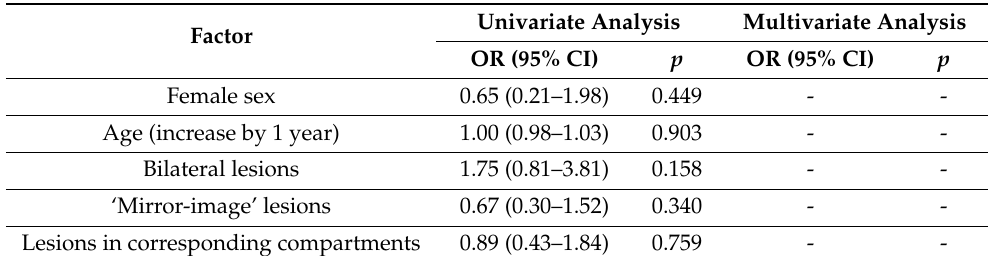
Table 8. Logistic regression for the dependent variable of seropositive RA vs. the independent variable of seronegative RA considering the types of symmetry.